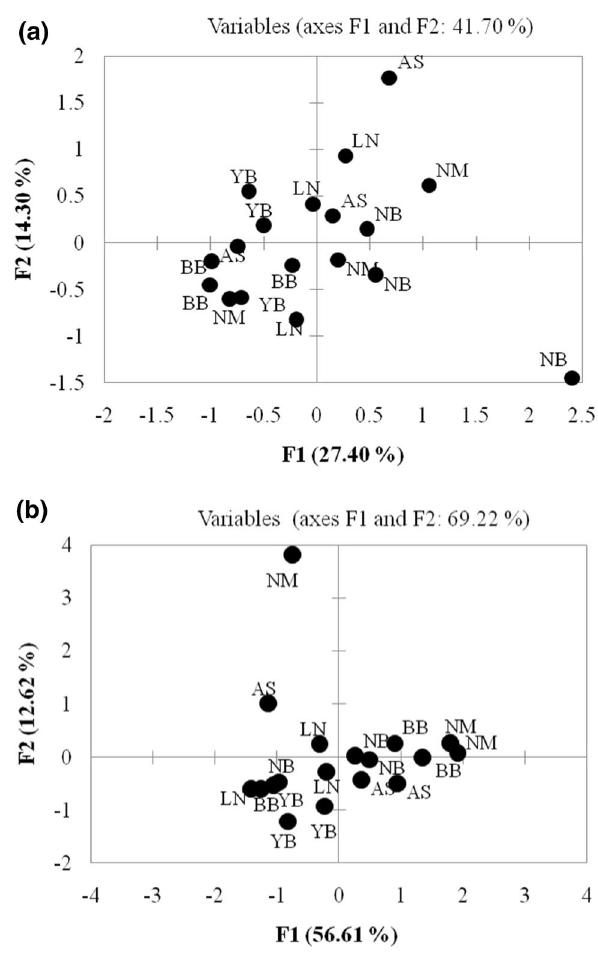
Fig. 9 Factor separation showing variability of water sampling points in terms of bacterial count ( a ) and physico-chemical analysis ( b ) of the Mezam